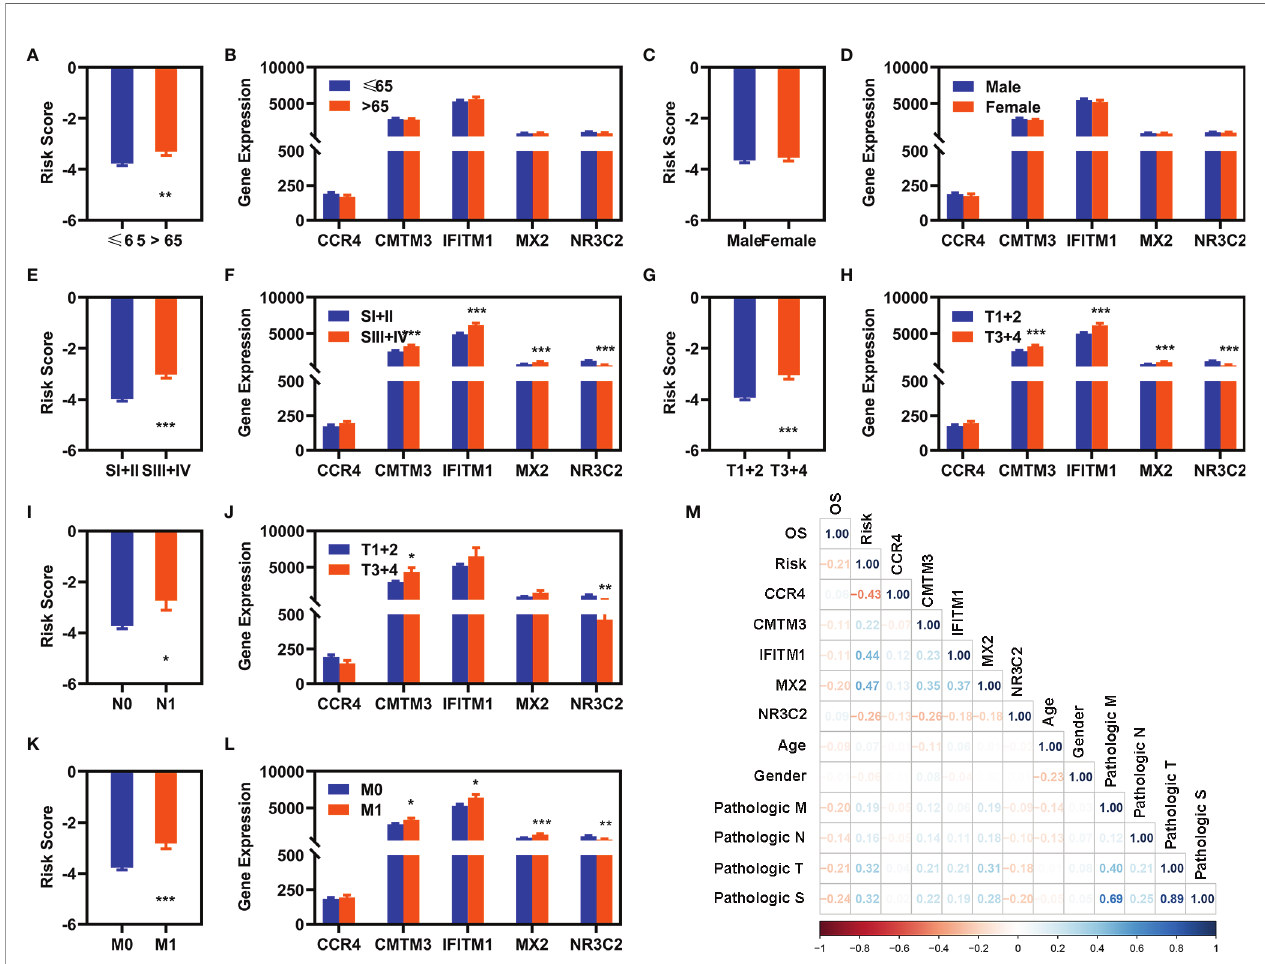
FIGURE 4 | Correlation analyses with clinical features. (A , C , E , G , I , K) Differentially expression analyses of risk value with clinical different features in the entire cohort [ (A) age, (C) gender, (E) pathological S, (G) pathological T, (I) pathological (N) , and (K) pathological (M) ]. (B) , (D) , (F) , (H) , (J) , (L) Differentially expression of these fi ve FI-DEGs with clinical features in the entire cohort [ (A) age, (C) gender, (E) pathological S, (G) pathological T, (I) pathological (N) , and (K) pathological (M) ]. (M) Correlation analyses of these fi ve FI-DEGs and risk value with the clinical features in the entire cohort. N ( ≤ 65) = 348, n (>65) = 182. N (Male) = 344, N (Female) = 186. N (SI + II) = 322, N (III + IV) = 205. N (T1 + 2) = 340, N (T3 + 4) = 190. N (N0) = 239, N (N1) =16. N (M0) = 420, N (M1) = 78. *p < 0.05, **p < 0.01, ***p <